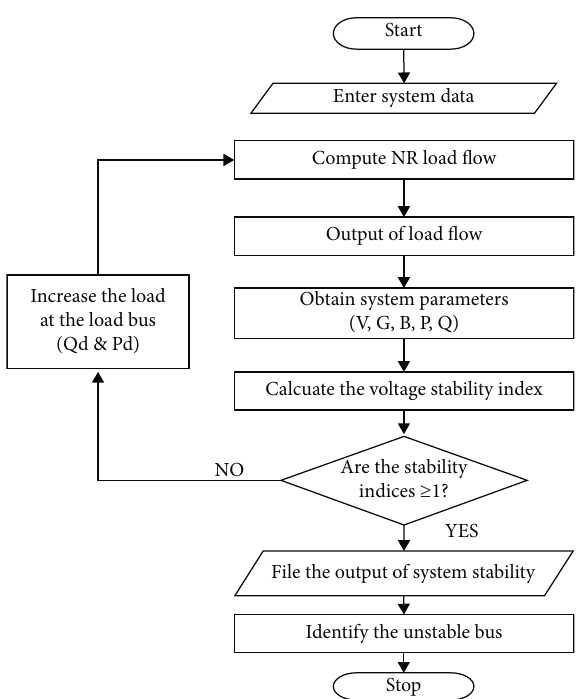
Figure 3: Flow charts of voltage stability